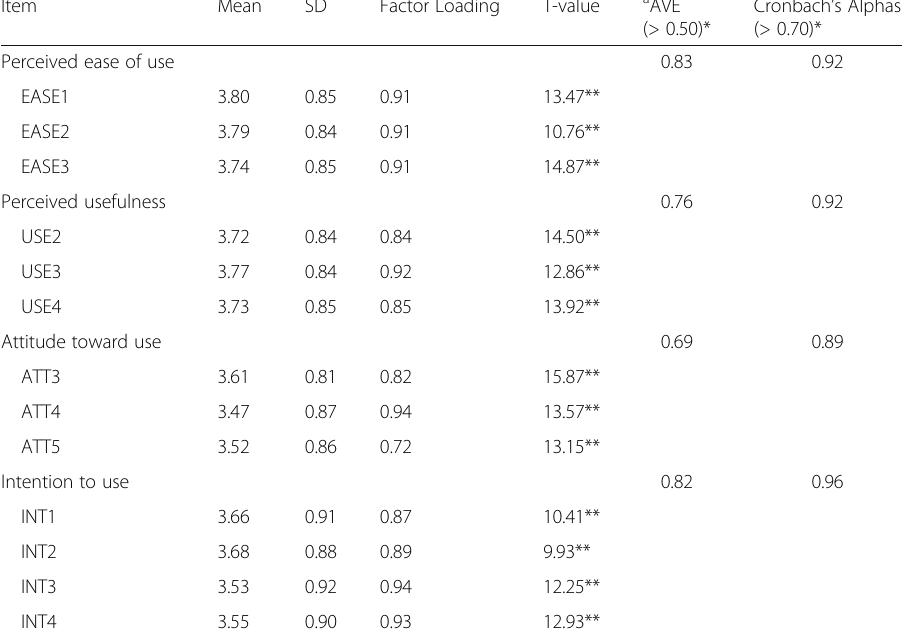
Table 2 Results of the Measurement